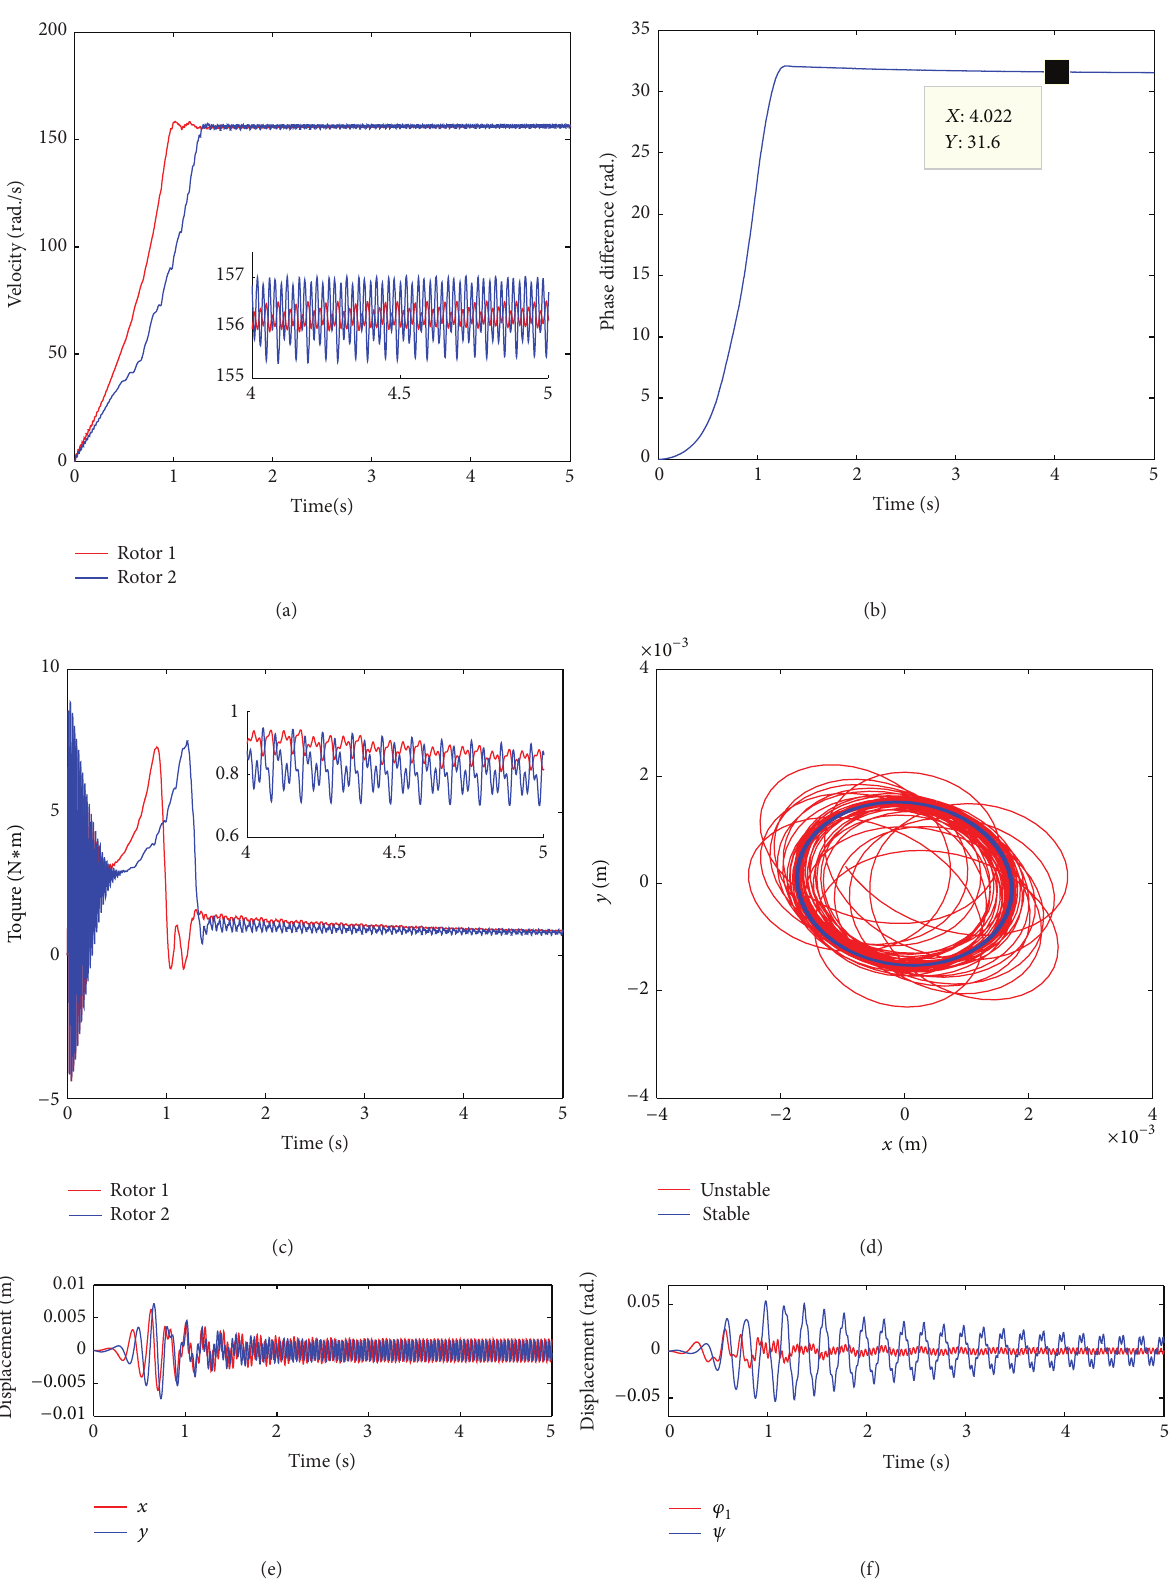
Figure 11: Simulation results for asymmetry rotors system: (a) rotational velocity, (b) phase difference of the two rotors, (c) torques of the two rotors, (d) trajectory of mass center of the vibrobody, (e) displacement responses of the vibrobody in 𝑥 - and 𝑦 -directions, and (f) displacement responses of the vibrobody in 𝜑 1 - and 𝜓